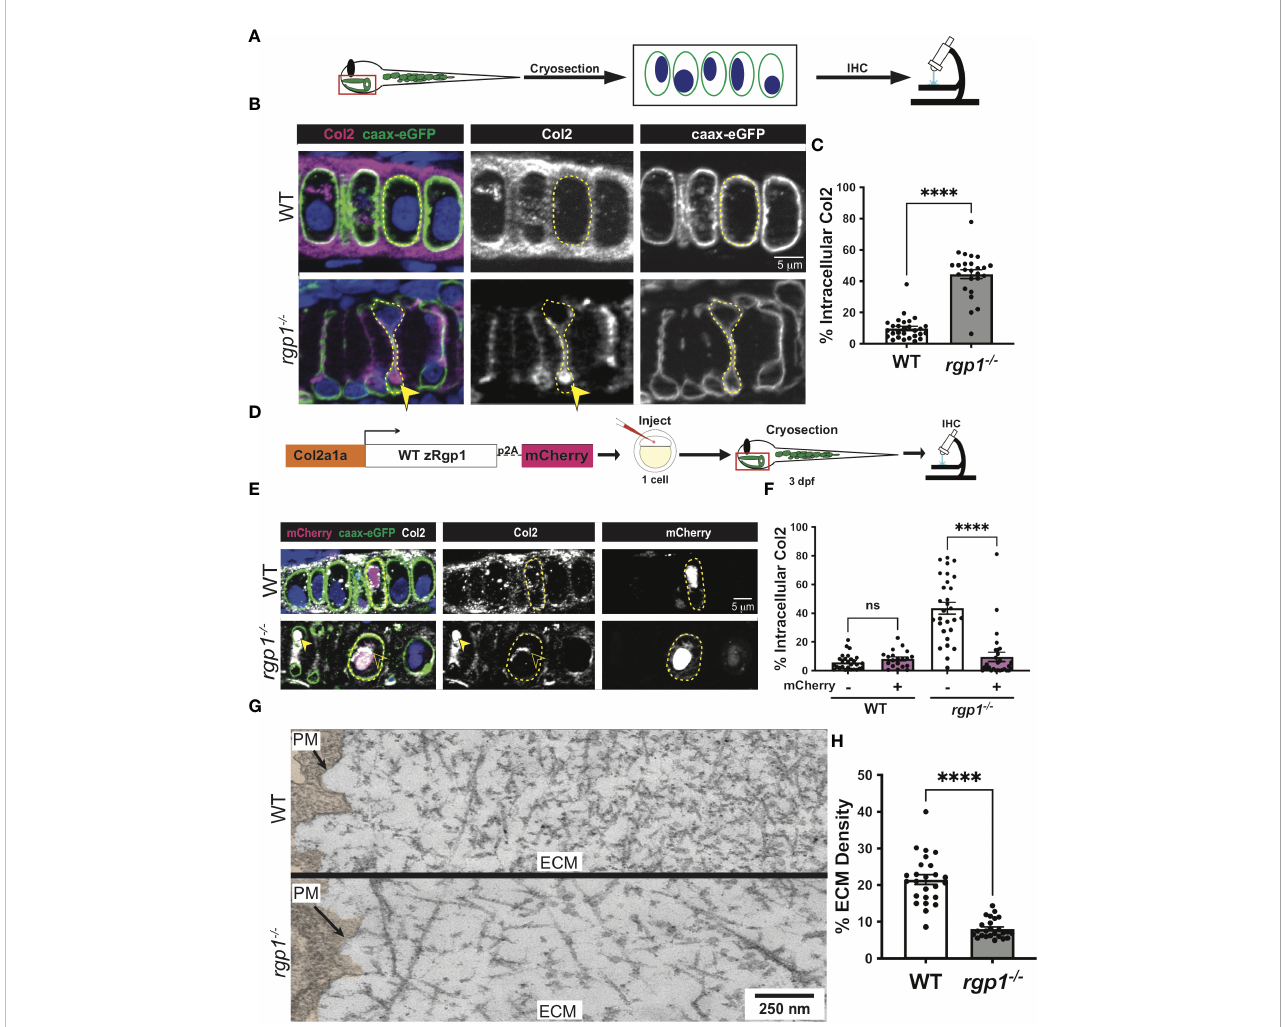
FIGURE 3 Rgp1 -/- chondrocytes accumulate collagen II intracellularly. (A) Experimental design for immunohistochemical analysis of chondrocytes in the craniofacial head skeleton. (B) Representative images of Tg(Col2a1 a :caax-eGFP) transgenic larvae in WT and rgp1 -/- cartilage (Col2, magenta; eGFP, green). Yellow arrowhead identi fi es intracellular collagen II. (C) Quanti fi cation of the percentage of cytosolic area occupied by collagen II signal in chondrocytes. (D) Experimental design for mosaic overexpression of zRgp1-p2A-mCherry in zebra fi sh chondrocytes. (E) Representative images of Tg (Col2a1 a :caax-eGFP) transgenic chondrocytes in WT and rgp1 -/- cartilage (mCherry, magenta; eGFP, green; Col2, white). Yellow arrowhead identi fi es collagen II in mCherry - cells while empty arrowhead identi fi es collagen II in mCherry + cells. (F) Quanti fi cation of the percentage of cytosolic area occupied by collagen II signal in chondrocytes. (G) TEM images of chondrocyte membranes and adjacent ECM proteins. (H) Quanti fi cation of TEM staining density from craniofacial chondrocyte plasma membrane to edge of cartilage tissue using ImageJ. Signi fi cance is presented by ****p<0.0001; ns, not sign fi